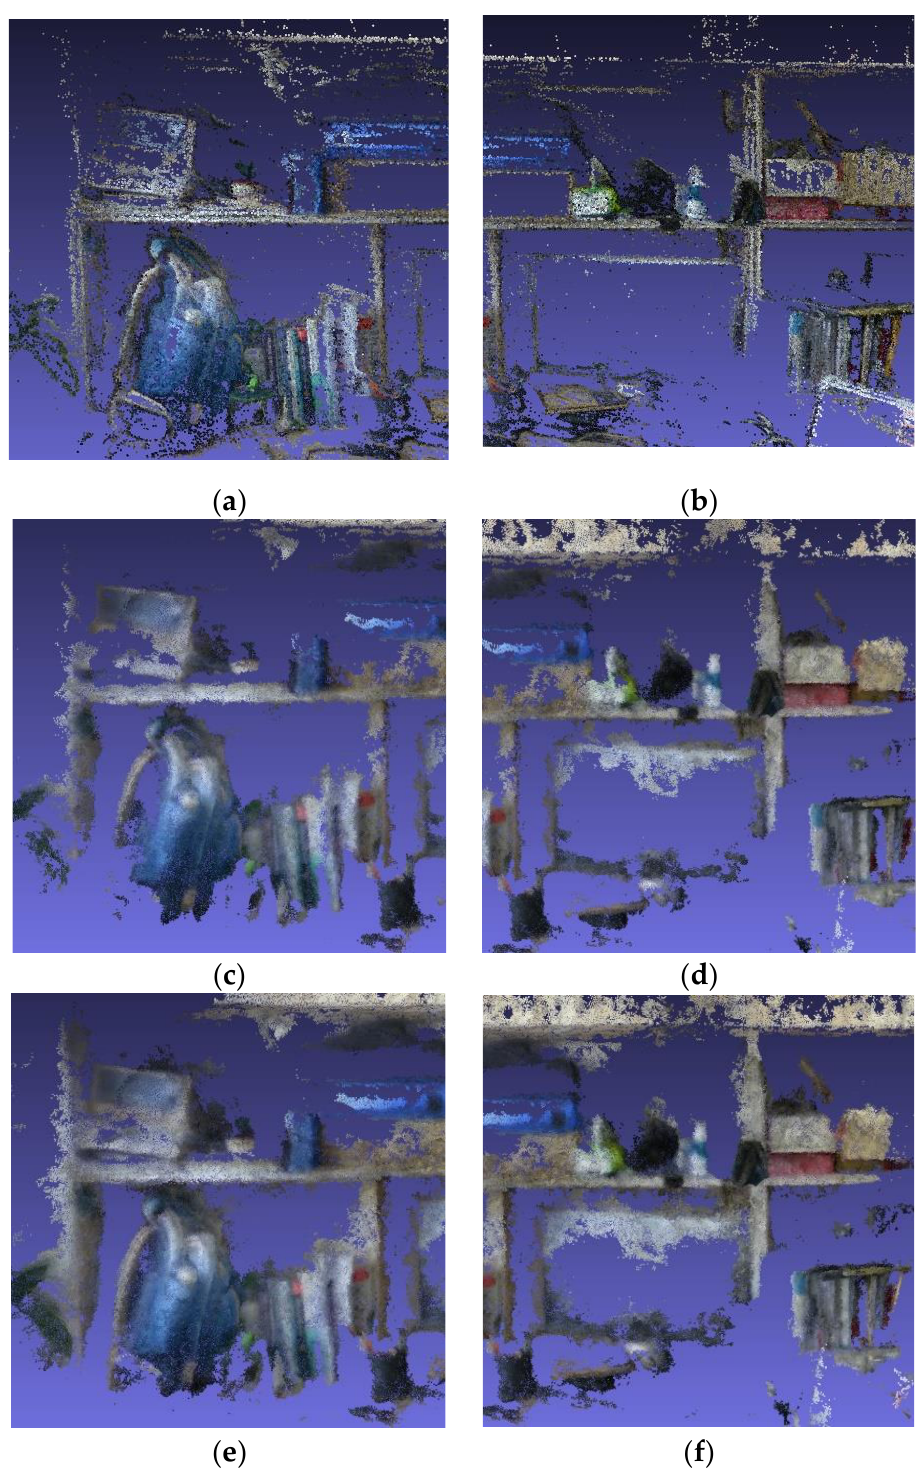
Figure 23. Detailed 3D reconstruction results of the different methods. ( a , b ) Traditional method; ( c , d ) MVSNet; ( e , f ) CES-MVSNet.